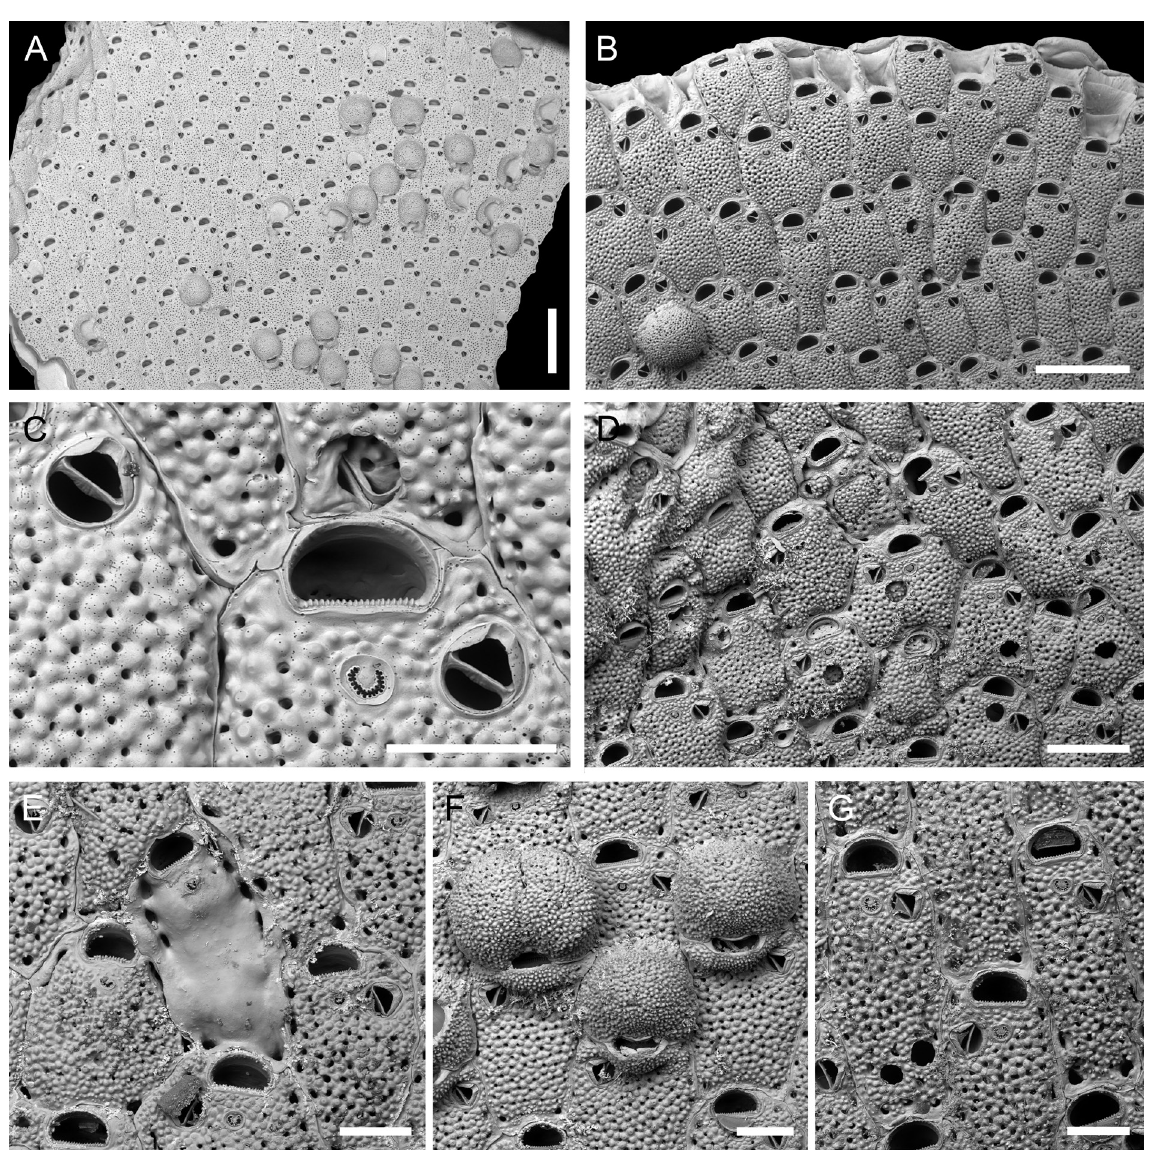
Fig. 6. Microporella hyadesi (Jullien, 1888), Recent, Discovery Expedition. A–D . NHMUK 1990.10.22.14. A . General view of a branch fragment. B . Group of zooids, one ovicellate, at the growing edge of the branch. Note the growing edge intermediate between a smooth and a stepped edge. C . Close- up of the orifice, ascopore and adventitious avicularia. Note also the borehole patched by an avicularium (top centre). D . Group of zooids showing several repared boreholes and sealed orifices. E–F . NHMUK 1990.10.10.25. E . Aberrant autozooid with smooth, non-pseudoporous frontal shield. F . Close-up of three ovicellate zooids, the ovicell on the left showing teratology. G . NHMUK 1990.10.31.12, autozooids with adventitious avicularia preserving triangular mandibles. Scale bars: A–B = 1 mm; C, E –G = 200 µm; D = 400